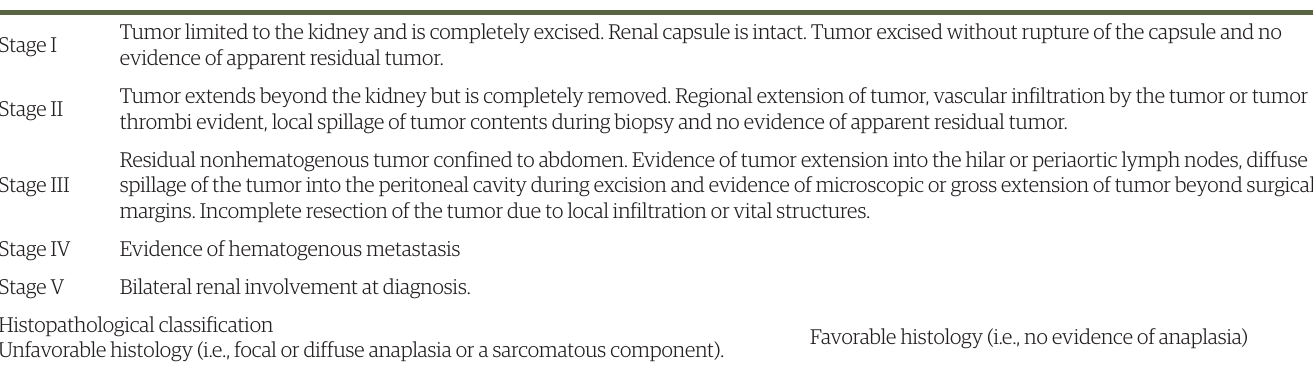
Table 1. The staging system for nephroblastoma in humans, developed by the National Wilms’ Tumor Study Group (D’Angio et al., 1976).